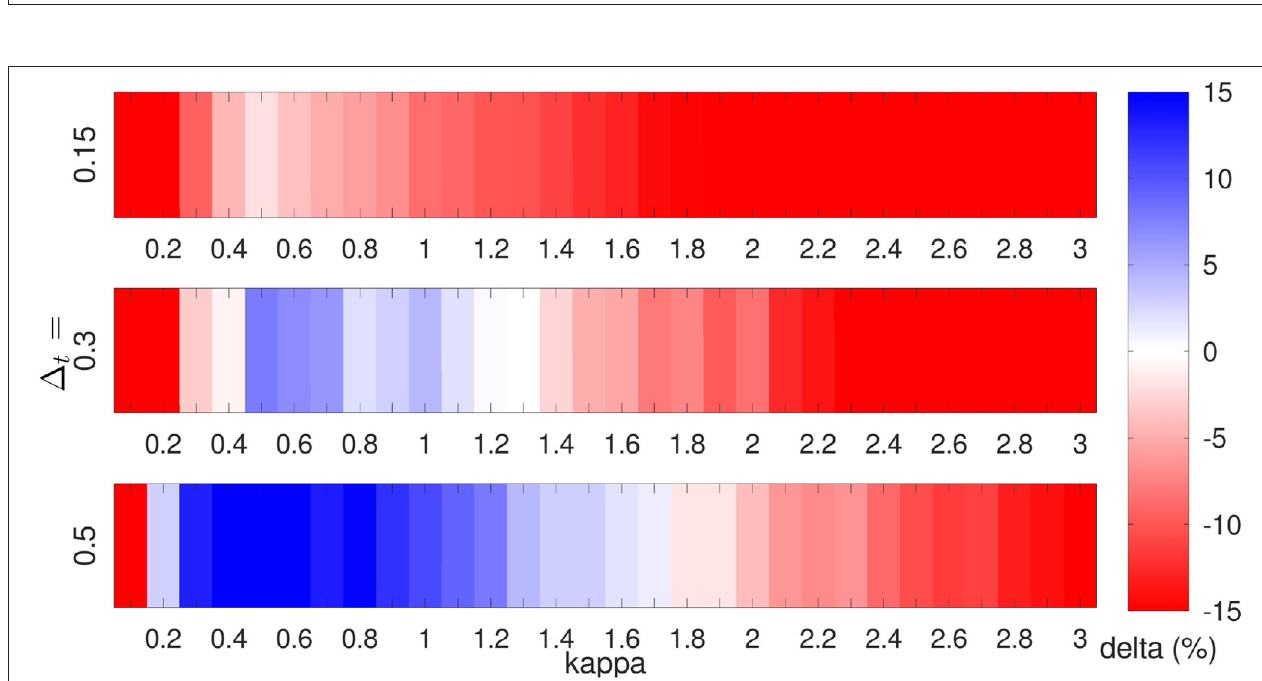
FIGURE 5 | A thousand particles drawn from a Gaussian distribution (red points) are integrated in time with respect to the Lorenz 1963 model dynamics for 1 t (blue), 1 t 0.3 (lightblue) and 1 t 0.5 (cyan) time units. = =